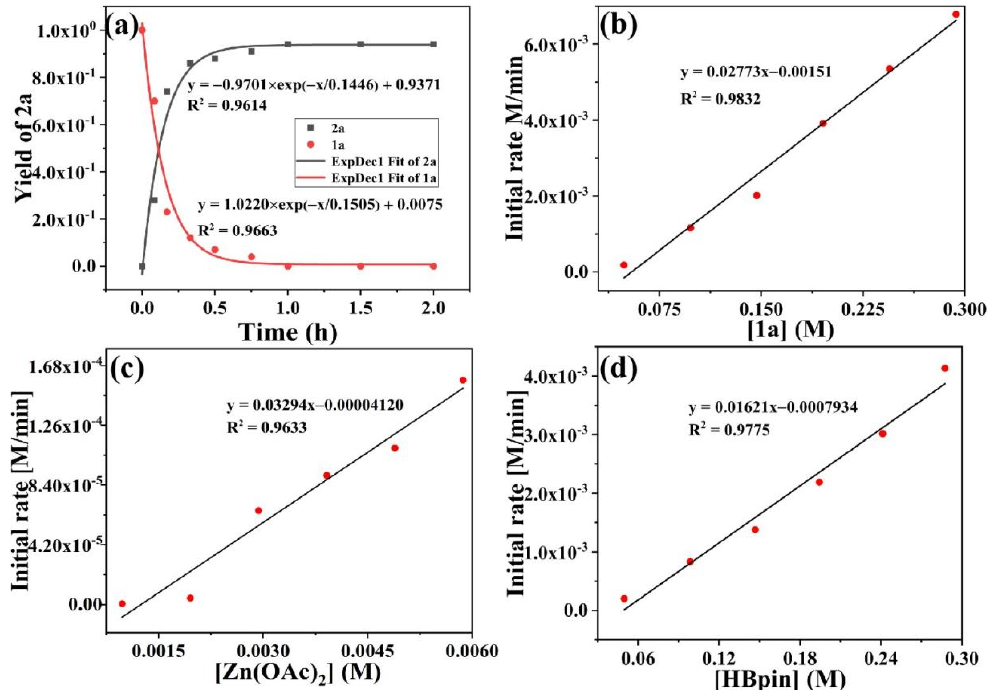
Figure 1. Kinetic profiles for Zn-catalyzed reduction of 1a : ( a ) reaction profile of Zn-catalyzed reduction of 2-naphthaldehyde, ( b ) initial reaction rate against the concentration of 1a , ( c ) initial reaction rate against the concentration of catalyst of Zn(OAc) 2 , ( d ) initial reaction rate against the concentration of